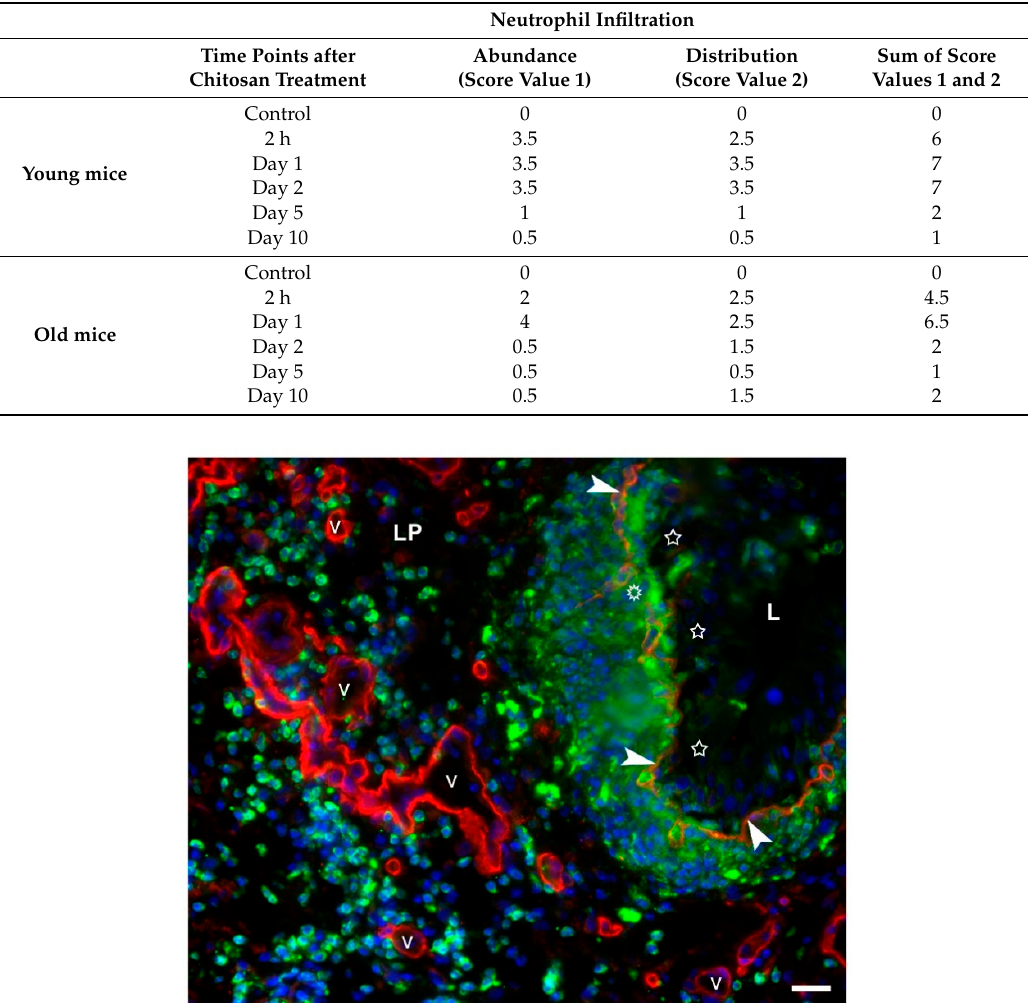
Table 1. Scoring results of neutrophil infiltration in the urinary bladder wall of young and old mice.